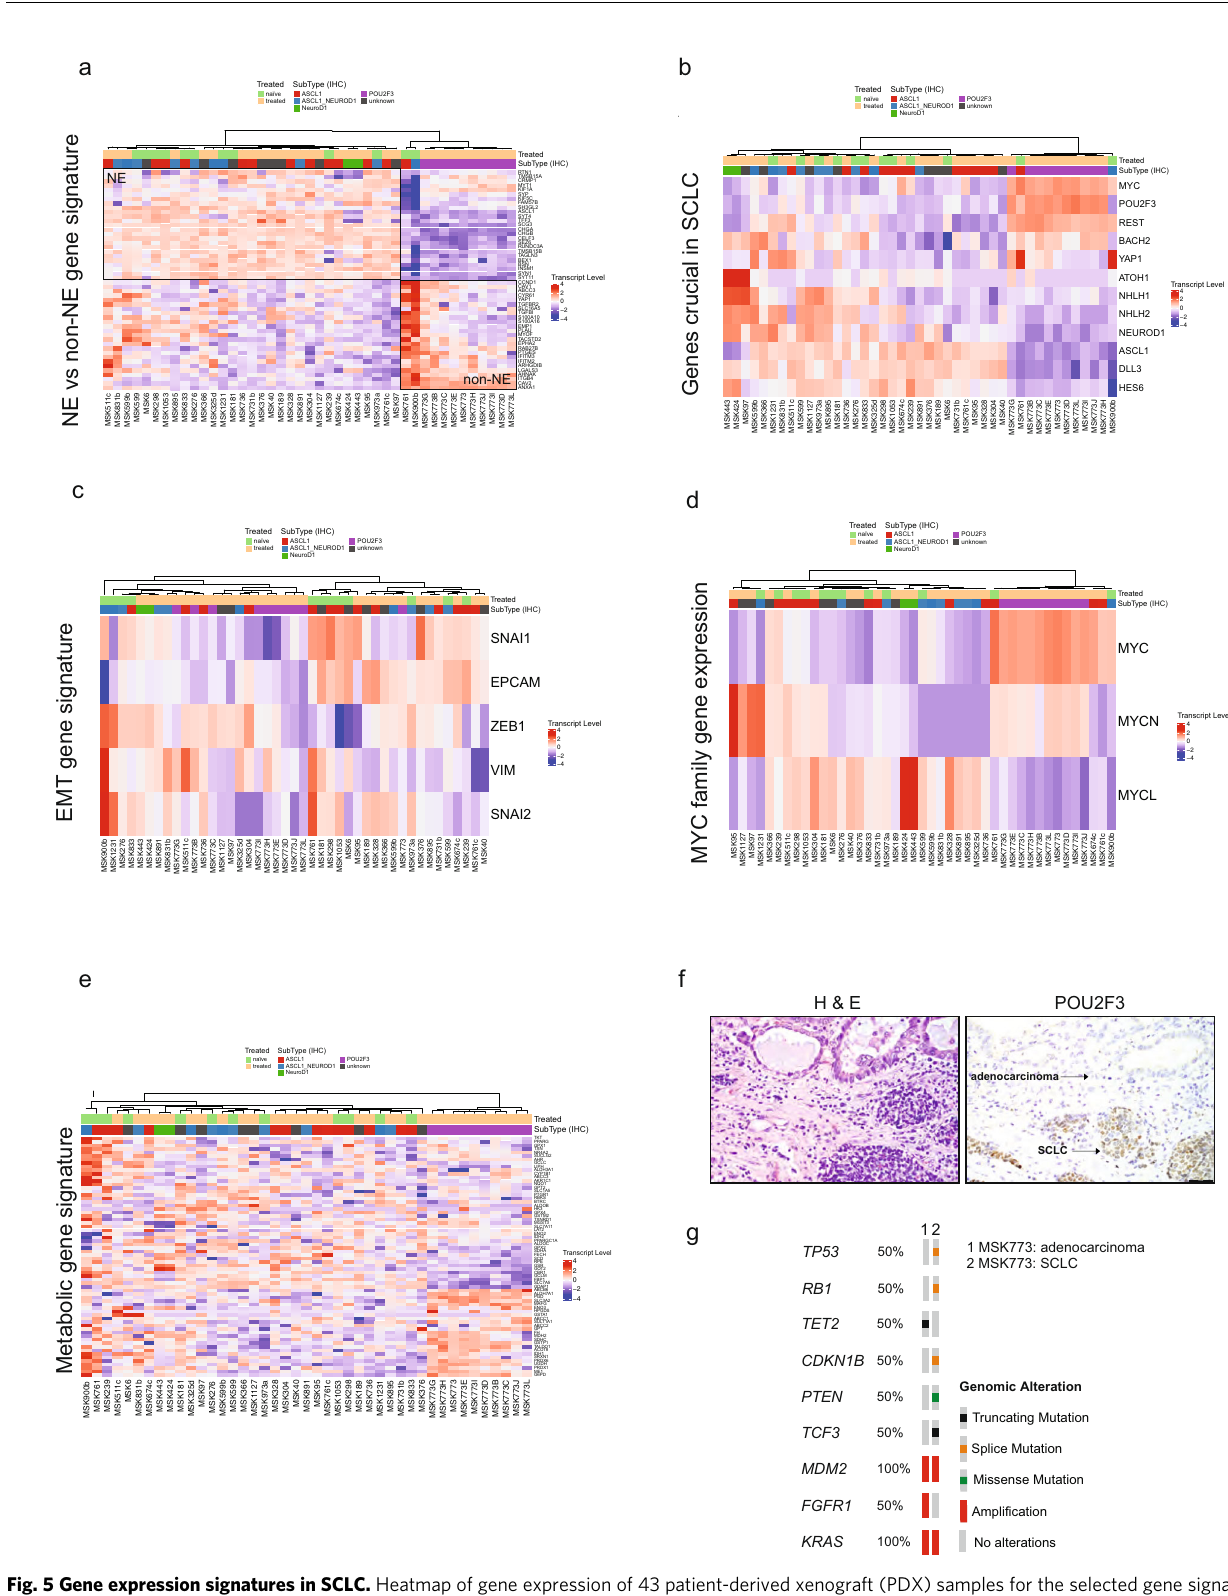
Fig. 5 Gene expression signatures in SCLC. Heatmap of gene expression of 43 patient-derived xenograft (PDX) samples for the selected gene signatures; neuroendocrine (NE) vs. non-NE gene signature 32 ( a ), genes crucial in SCLC ( b ), EMT gene signature ( c ), MYC family gene expression ( d ), and metabolic gene signature 42 ( e ). Color-coded panel on top depicts treatment status (naïve or treated) and subtype annotation based on IHC. Source data are provided as a Source Data fi le. f H&E and immunohistochemistry image for POU2F3 are shown for the clinical MSK773. Scale bar as indicated, 20 μ M. g Genomic landscape in MSK773A (adenocarcinoma) vs. MSK773A (SCLC) samples representing putative driver alterations (i.e. excludes variants of unknown signi fi cance) in altered genes as detected by MSK-IMPACT 20 targeted next-generation sequencing